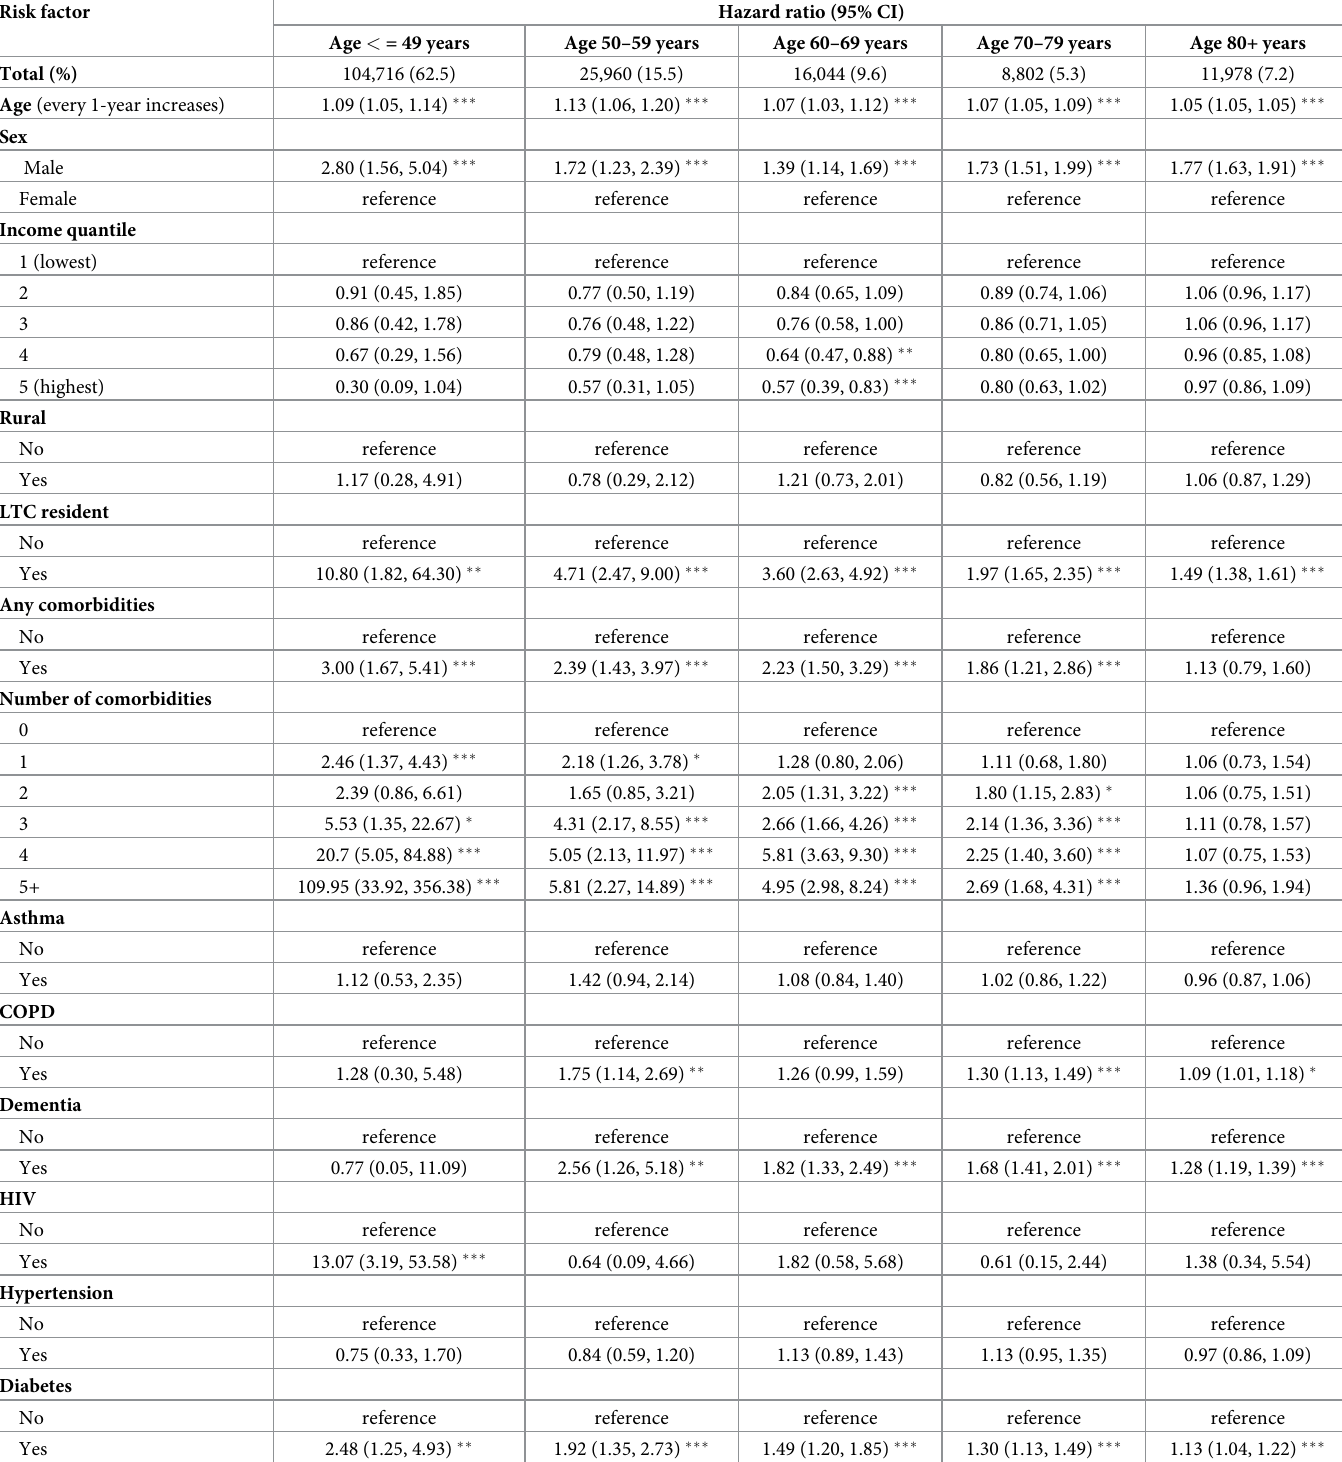
Table 2. Age groups based analyses regarding associations of demo-socio-economic characters and comorbidities with all-cause 30-day mortality by Cox propor- tional hazards